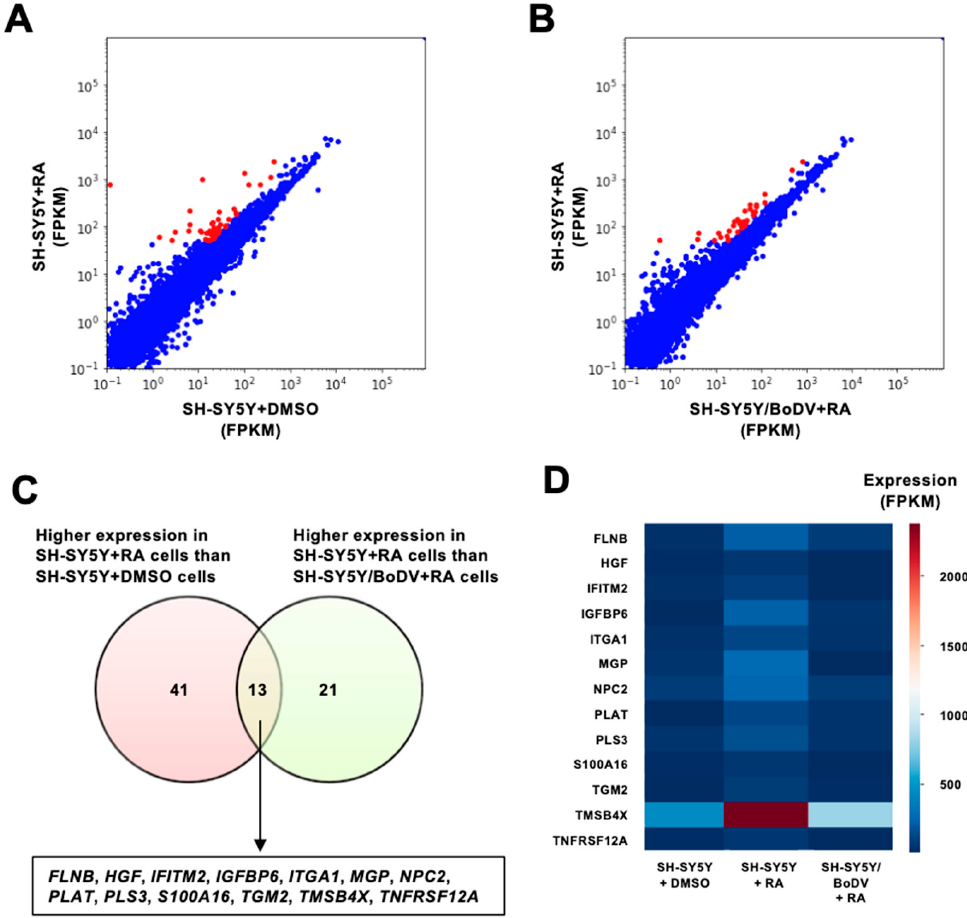
Figure 2. Differentiation-related genes affected by BoDV-1 infection. ( A , B ) Scatter plots of RNA-seq Figure 2. Di ff erentiation-related genes a ff ected by BoDV-1 infection. ( A , B ) Sca tt er plots of RNA-seq analysis. Extracted genes are indicated in red. ( A ) Comparison between undi ff erentiated (X-axis) analysis. Extracted genes are indicated in red. ( A ) Comparison between undifferentiated (X-axis) and and di ff erentiated (Y-axis) SH-SY5Y cells. ( B ) Comparison between di ff erentiated SH-SY5Y/BoDV differentiated (Y-axis) SH-SY5Y cells. ( B ) Comparison between differentiated SH-SY5Y/BoDV (X-axis) (X-axis) and di ff erentiated SH-SY5Y cells (Y-axis). ( C ) Venn diagram showing the number of and differentiated SH-SY5Y cells (Y-axis). ( C ) Venn diagram showing the number of differentiation- di ff erentiation-related (left circle) and BoDV-1-impaired (right circle) genes identi fi ed by RNA-seq. related (left circle) and BoDV-1-impaired (right circle) genes identified by RNA-seq. The overlapped The overlapped genes are indicated. ( D ) Heatmap showing the expression levels of BoDV-1- genes are indicated. ( D ) Heatmap showing the expression levels of BoDV-1-impaired, differentiation- impaired, di ff erentiation-related genes. related